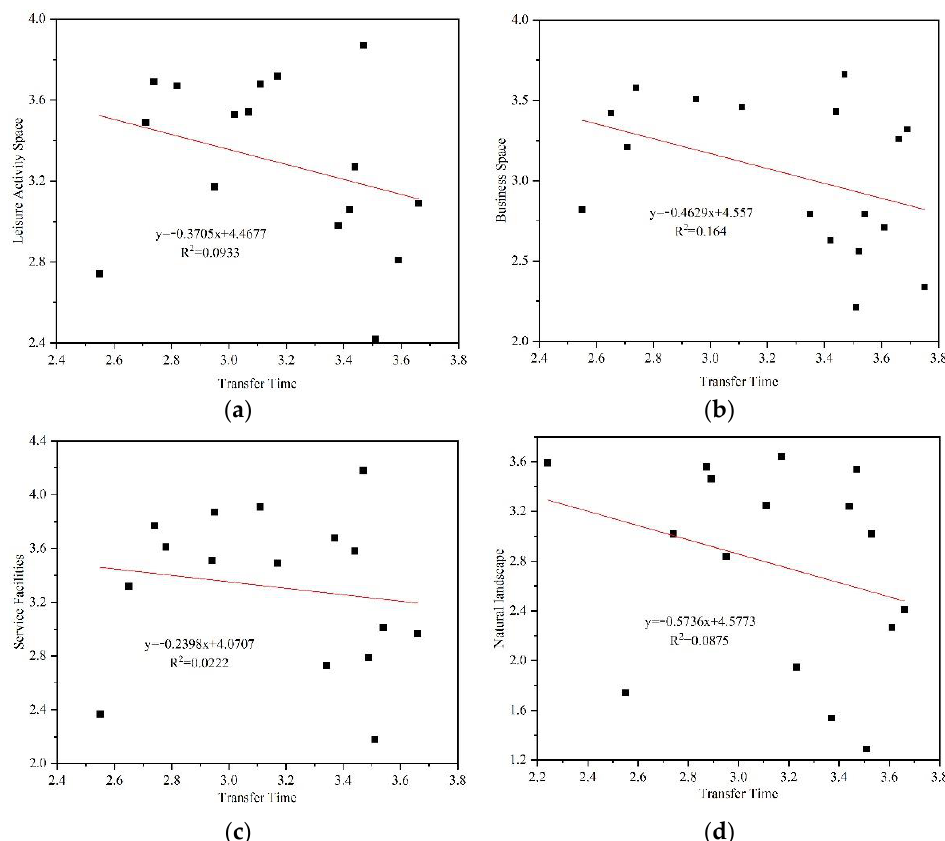
Figure 19. ( a ) Relevance of transfer route and leisure activity space; ( b ) relevance of transfer route and business space; ( c ) relevance of transfer route and service facilities; ( d ) relevance of transfer route and natural landscape.